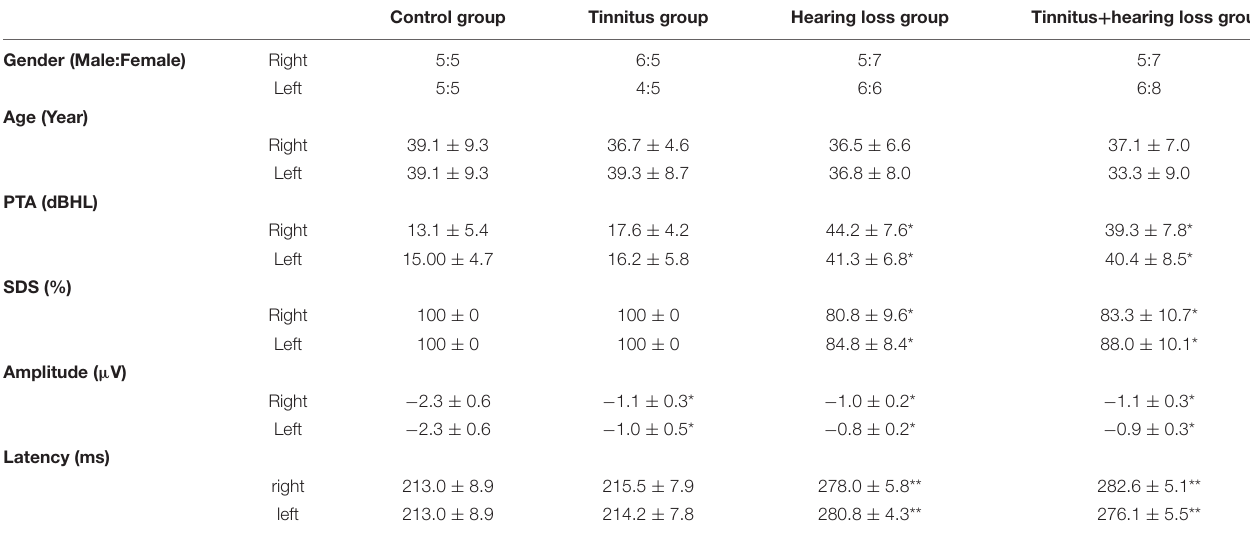
TABLE 1 | Sex, age, PTA, SDS, and MMN of the tinnitus patients and healthy control subjects. Control group Tinnitus